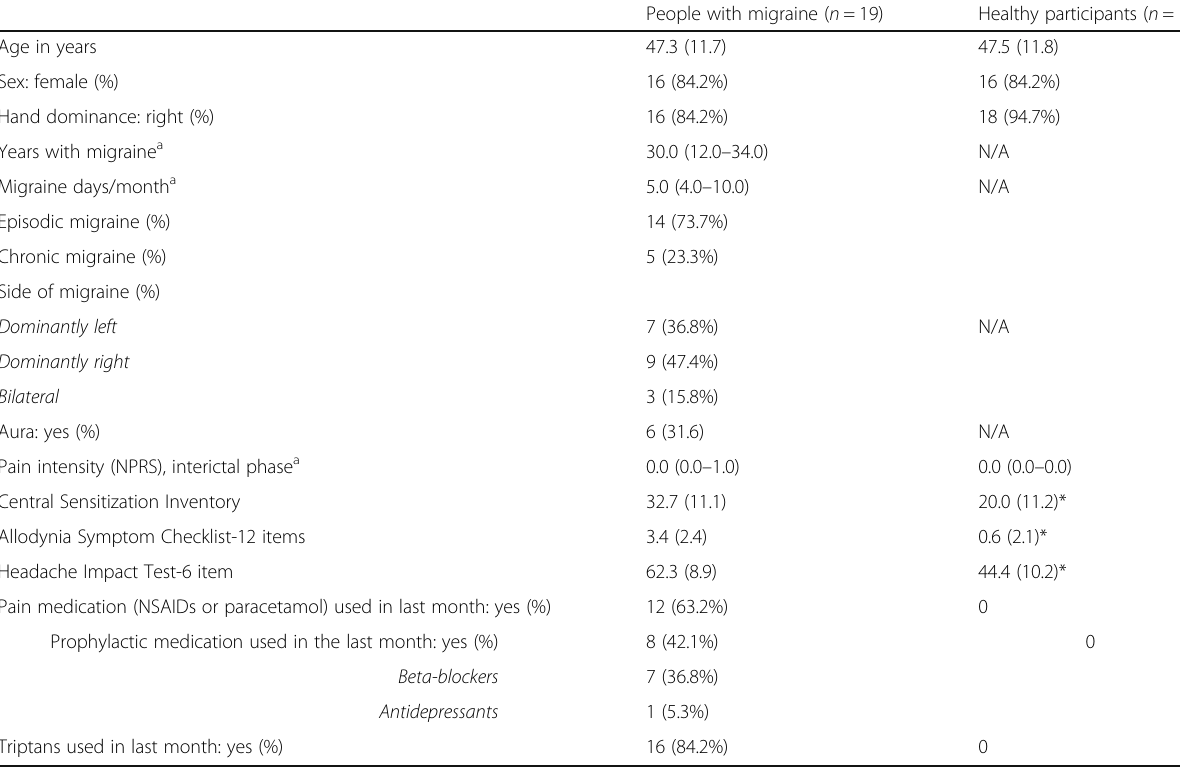
Table 1 Baseline characteristics for people with migraine and healthy participants